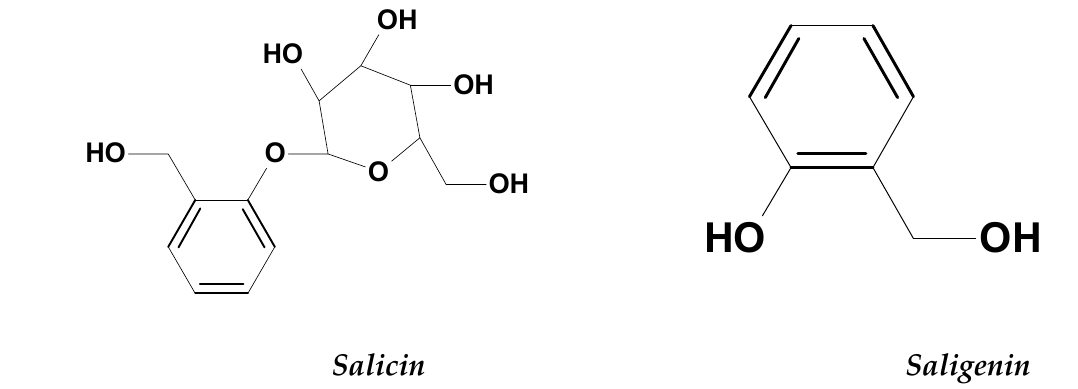
Figure 5. The structures of salicin and saligenin.